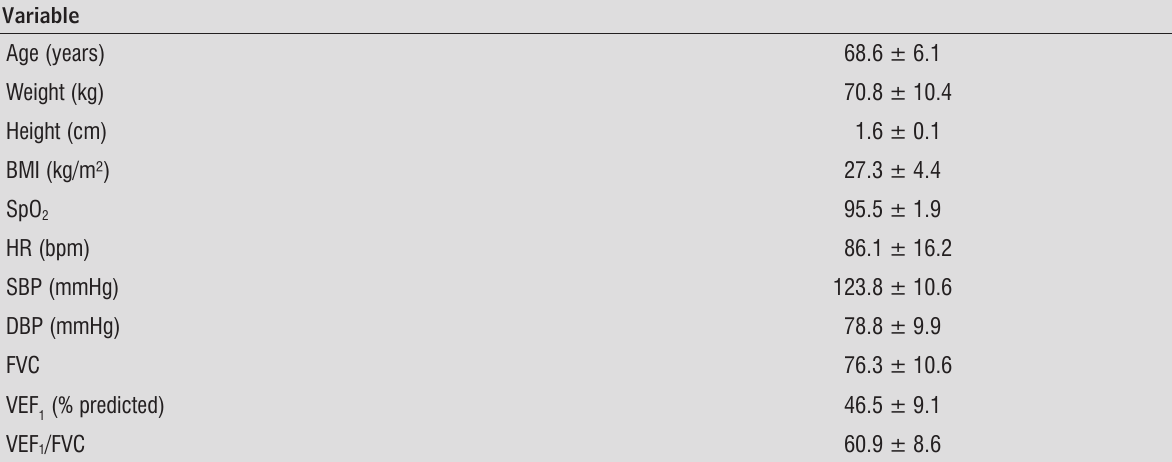
Table 1 - Population characteristics (n = 8)